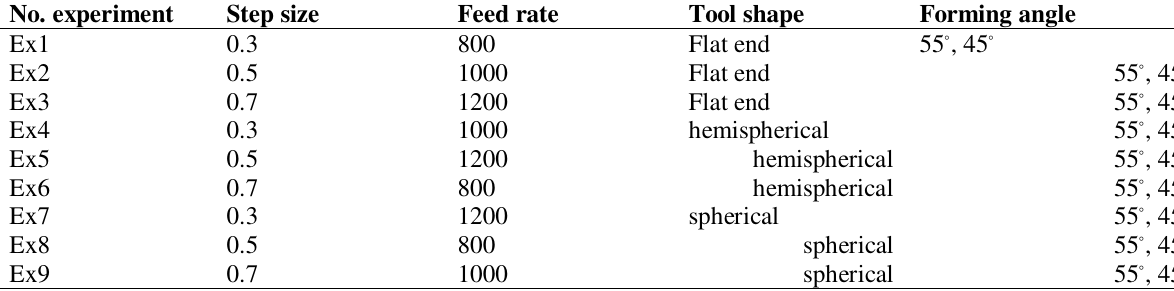
Matrix layout of the